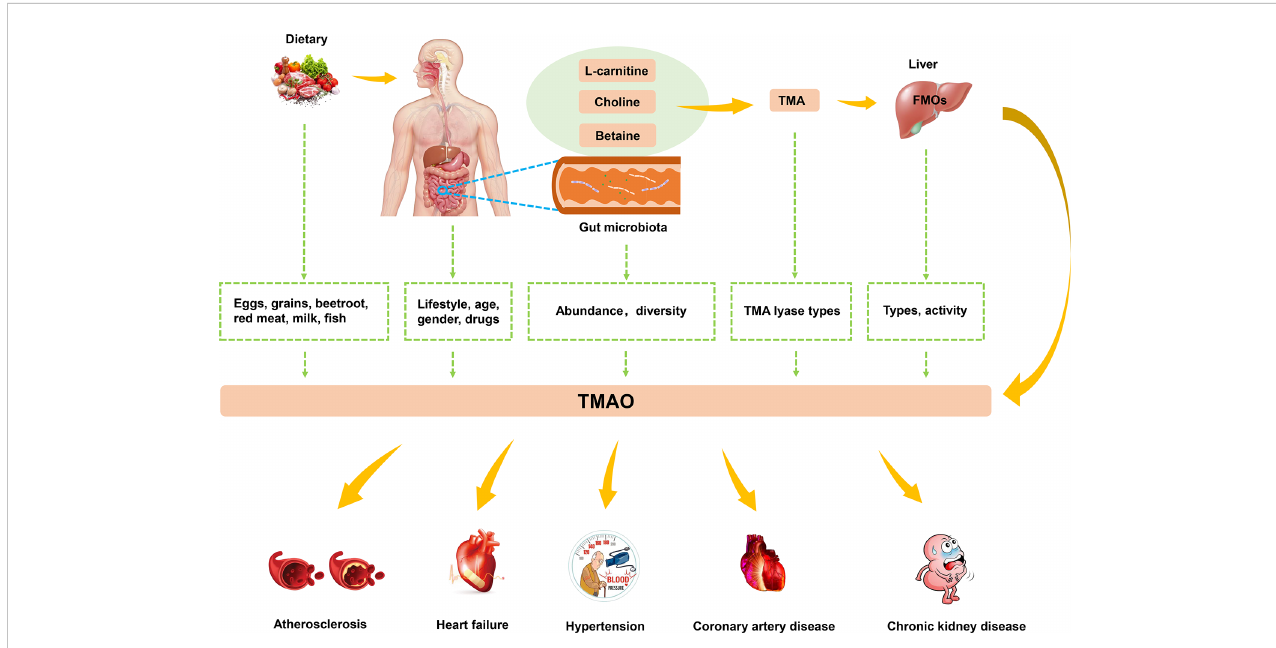
FIGURE 2 The biogenesis and metabolism of TMAO. Dietary choline or L-carnitine in food was metabolized to TMA by gut microbiota, which converted to TMAO by FMO3 in the liver. TMAO was closely related to the development of atherosclerosis, HF, hypertension and other